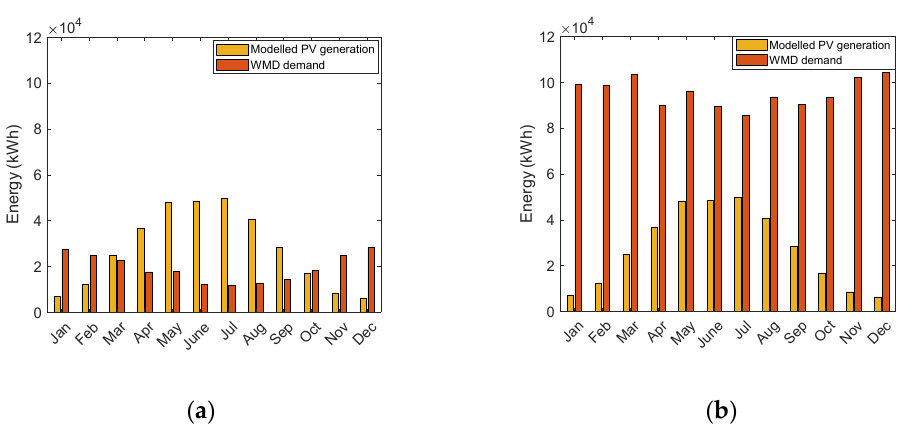
Figure 3. Monthly modelled PV solar energy generation and energy consumption at the WMD: ( a ) with a conventional RCV fleet; ( b ) with an eRCV